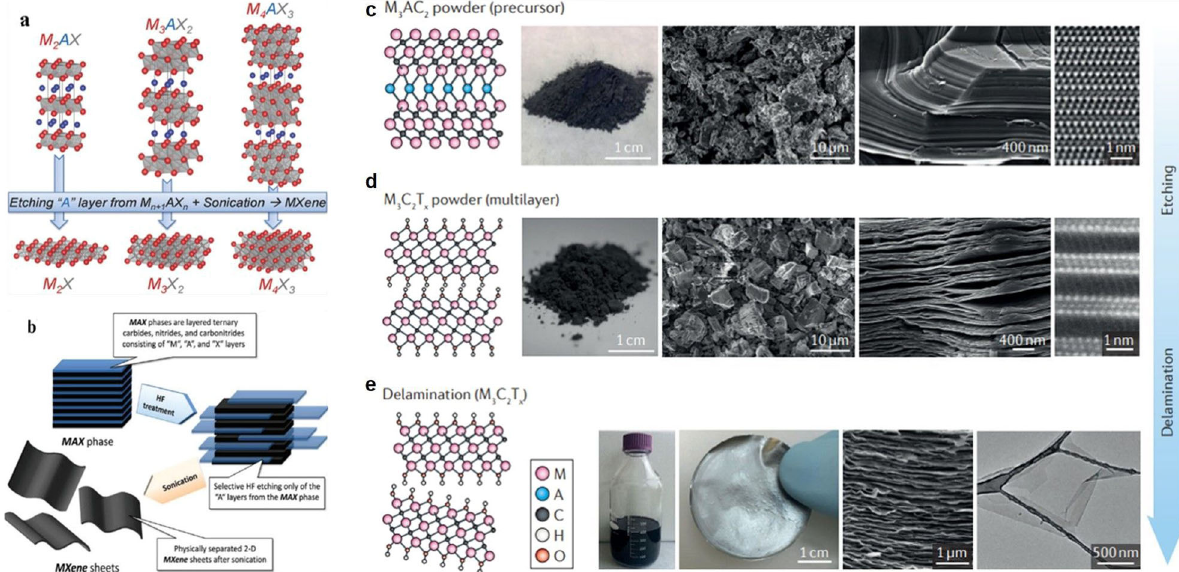
Fig. 2 The synthesis of MXenes from parent MAX phases. a The different structures of MAX phases and the respective MXenes. Reprinted with permission from 48 . b Schematic description of MXene synthesis procedure from MAX phases. a , b reprinted with permission from 54 ACS Nano 2012, 6, 1322-1331 Publication Date: January 26, (2012) https://doi.org/10.1021/nn204153h Copyright (2012) American Chemical Society; ( c – e ) Preparation and morphological characterization of MXenes. c Showing images of MAX structures (such as M 3 AC 2 ). From left-side to right- side: graphical illustration of the basic atomic structure, optical image of powder Ti 3 AlC 2 source, low and high magni fi ed FESEM micrographs of Ti 3 AlC 2 fl ake, and high-resolution TEM (HRTEM) image of Mo 2 TiAlC 2 . d Showing images of multilayered MXene. From left to right: graphical illustration of the basic atomic structure, optical image of Ti 3 C 2 T x powder, low and high-resolution FESEM images of Ti 3 C 2 T x and HRTEM image of Mo 2 TiC 2 T x . e Showing images of fi nal exfoliated MXene. From left-side to right-side: schematic illustration of the basic atomic structure, optical images of 400 ml of exfoliated Ti 3 C 2 T x in water, an optical image of the Mo 2 TiC 2 T x MXene fi lm formed by vacuum fi ltration, a cross- sectional FESEM image of the Mo 2 TiC 2 T x MXene fi lm, and a single-layer HRTEM image of the Ti 3 C 2 T x fl ake. Reprinted with permission from 19